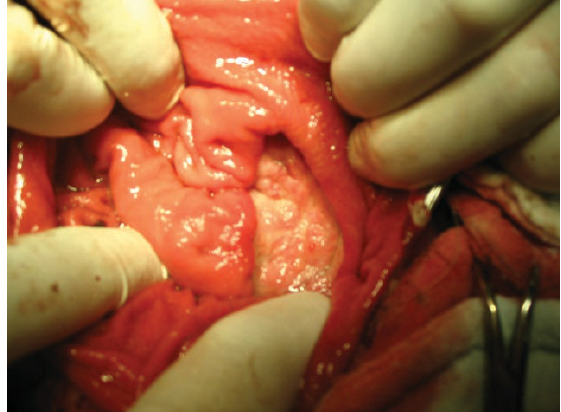
Figure 2. Ulcerous change on the back wall of the stomach caused by a trichobezoar.